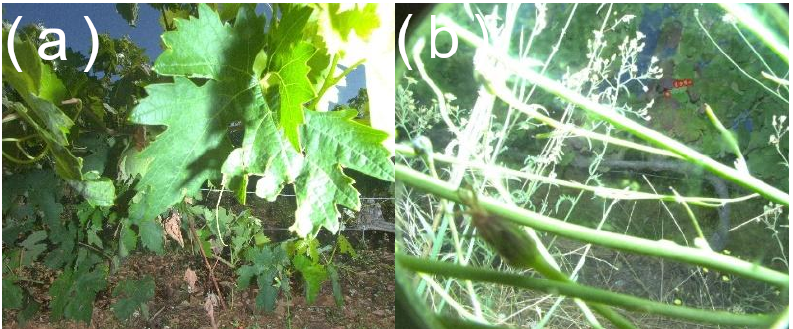
Figure 8. Example of images showcasing occlusion by ( a ) leaves and ( b )